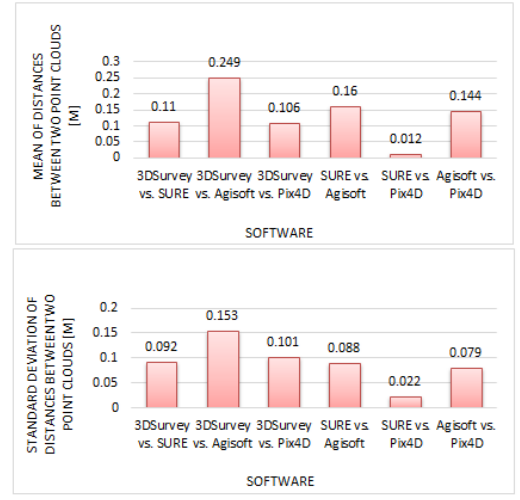
Figure 8. 3D distances [m] between two point clouds: the mean